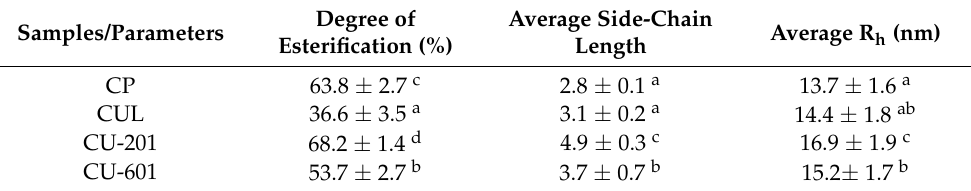
Table 1. Structural characteristics of pectin samples.